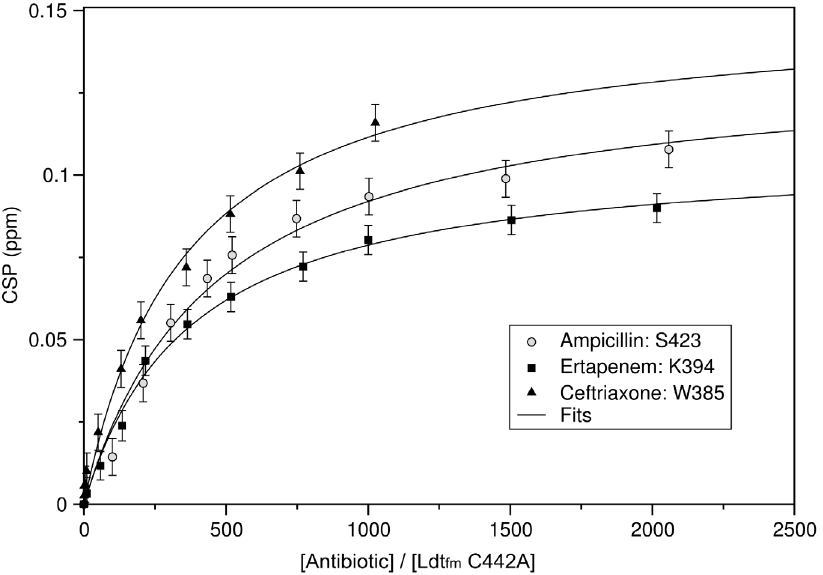
Figure 1. Chemical shift perturbations induced by non-covalent binding of b -lactams to Ldt fm C442A. Chemical shift perturbations (CSPs) of Ldt fm C442A residues are reported as a function of the antibiotic to protein molar ratio. Closed square, Lys394 for ertapenem; closed triangle, Trp385 for ceftriaxone; grey circle, Ser423 for ampicillin. The end point of the titration was determined by the solubility limit of the antibiotics. Experimental data were fitted (solid lines) with equation 2 described in the experimental procedures. K D values of 50, 44, and 79, mM were determined for binding of ertapenem, ceftriaxone, and ampicillin to Ldt fm C442A, respectively. Ertapenem was used as a representative of the carbapenem family since the low solubility of imipenem precluded K D determination for this antibiotic.